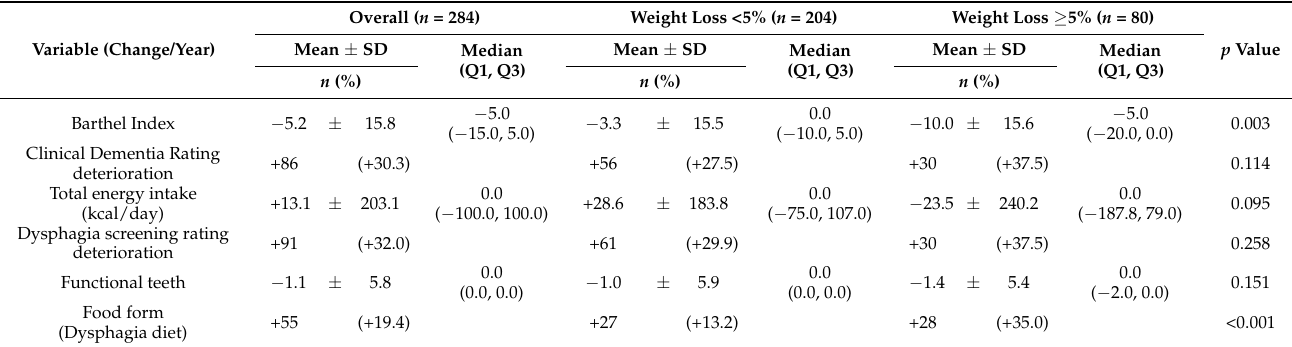
Table 3. Comparison of the weight loss and weight maintenance group according to the changes in the regular diet group for 1